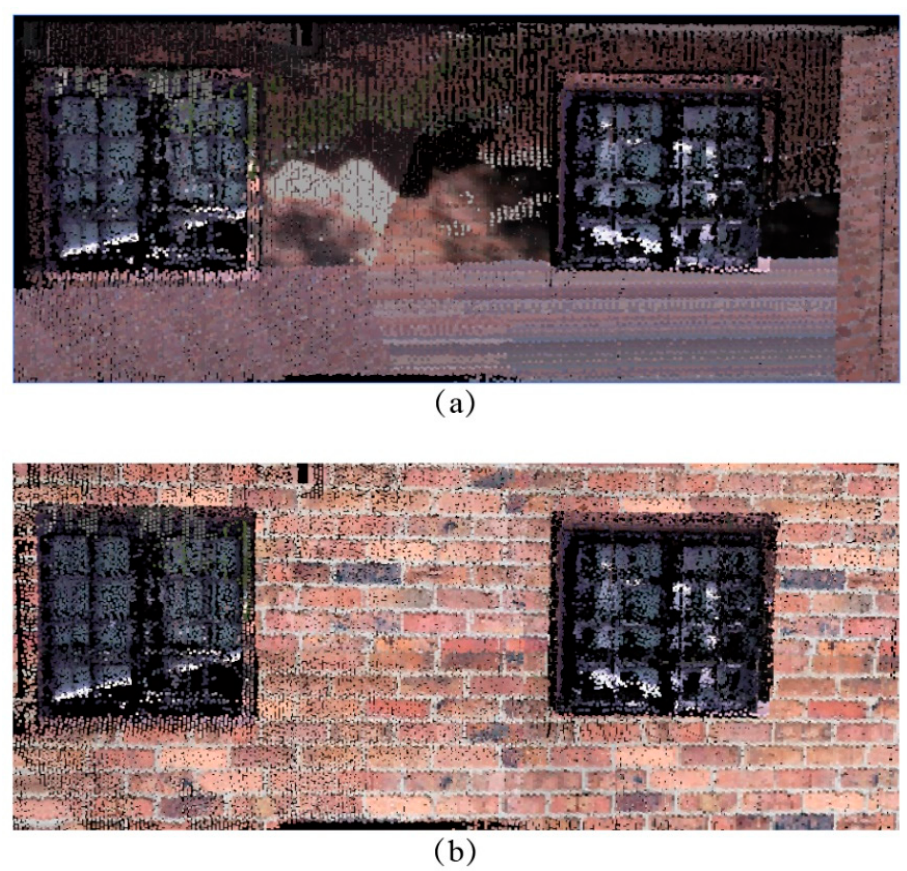
Figure 15. Point cloud of a brick wall with two windows of the Wesley House: ( a ) the original registered point cloud; ( b ) registered point cloud after the proposed colorization method is applied.